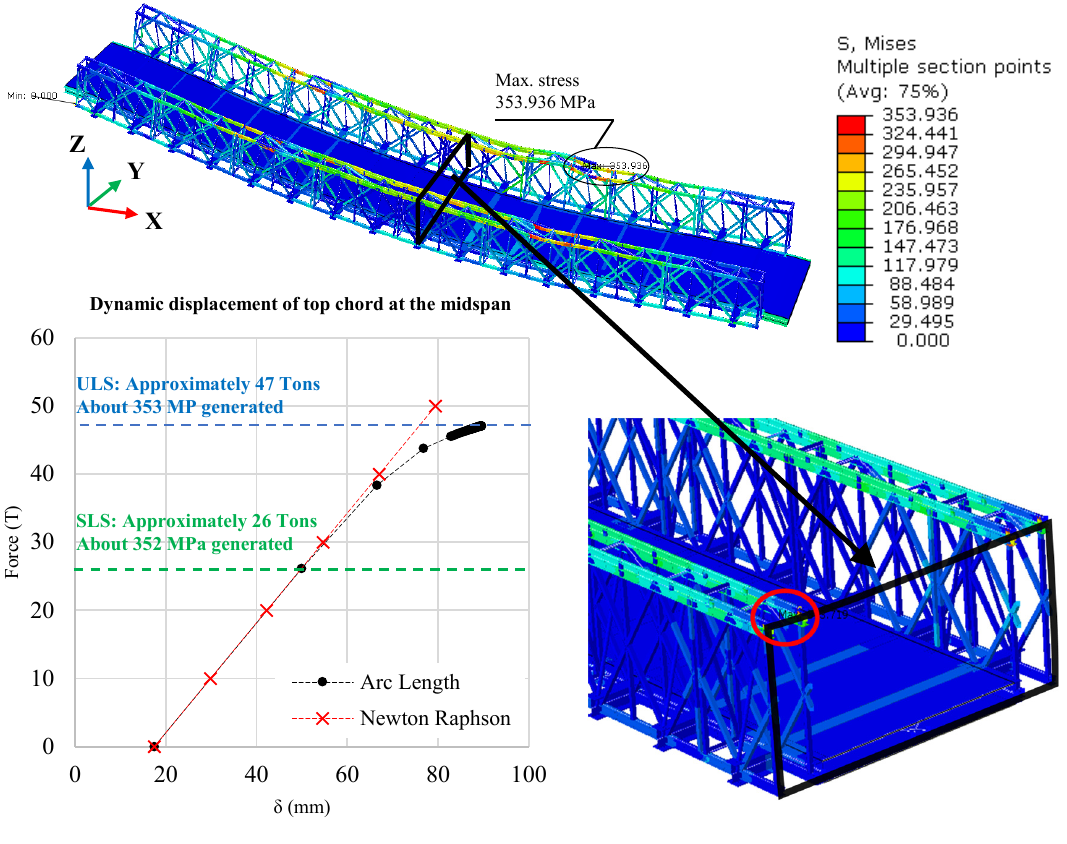
Figure 16. SLS and ULS.